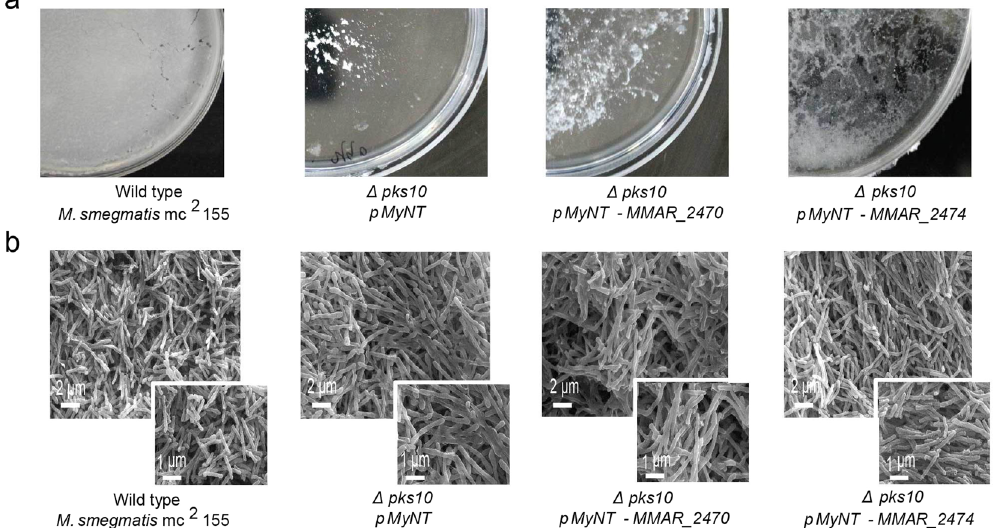
Figure 8. Biofilm development of ∆ pks10 Mycobacterium smegmatis strains complemented with Mmar type III PKSs. ( a ) Pellicle development and, ( b ) scanning electron microscopy (SEM) of biofilms of wild-type M. smegmatis (Msmeg), ∆ pks10 - pMyNT Msmeg, ∆ pks10 - pMyNT -MMAR_2470 Msmeg and ∆ pks10 - pMyNT - MMAR_2474 Msmeg